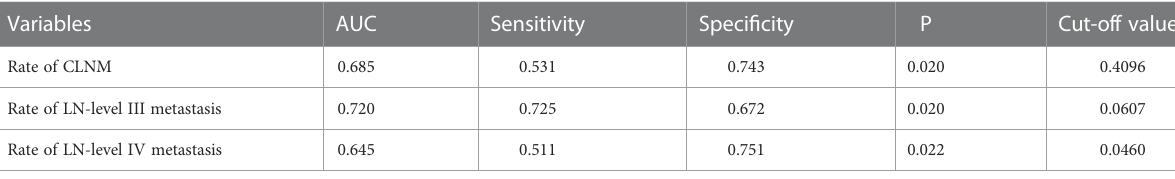
TABLE 2 The cut-off values of the Rate of different levels of LNM to predict LN-level II metastasis.